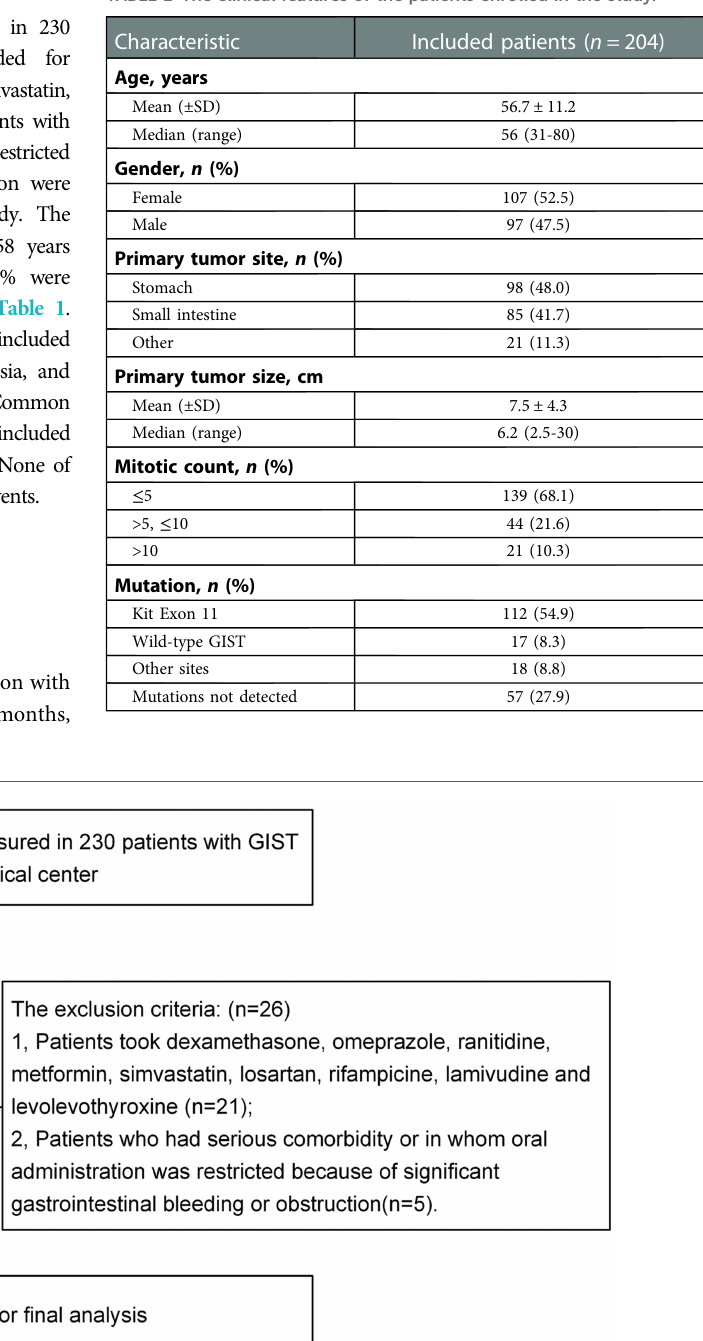
TABLE 1 The clinical features of the patients enrolled in the